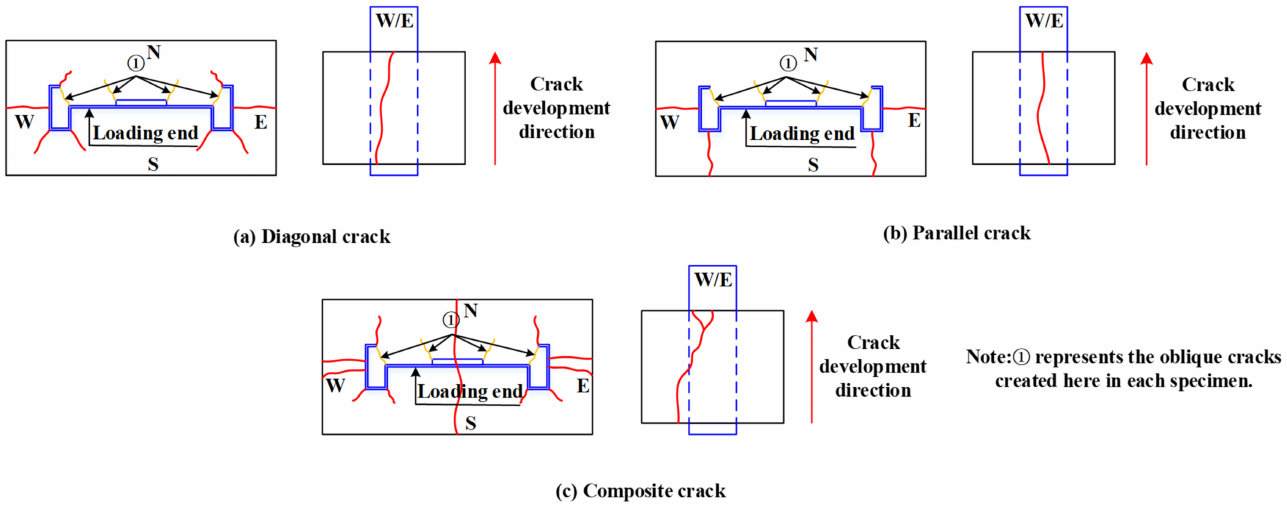
Figure 9. Typical crack